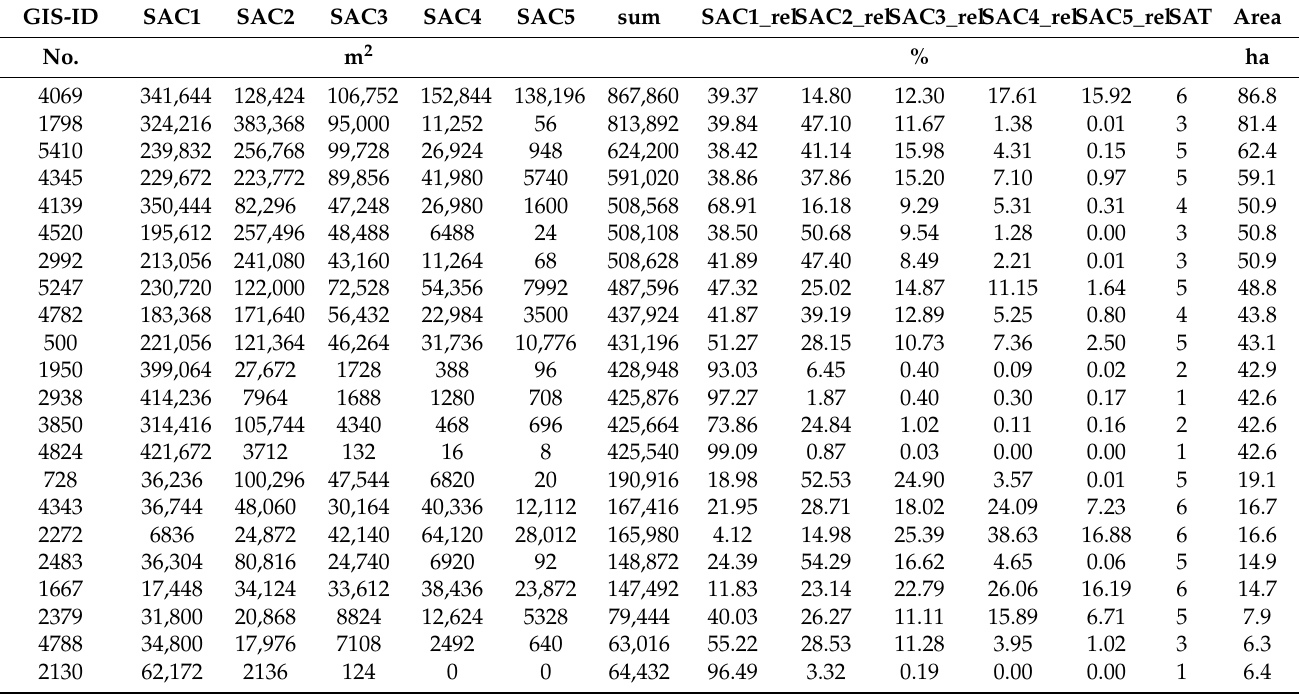
Table 5. Example of data sets of estimated slope association types; parcel is anonymized.